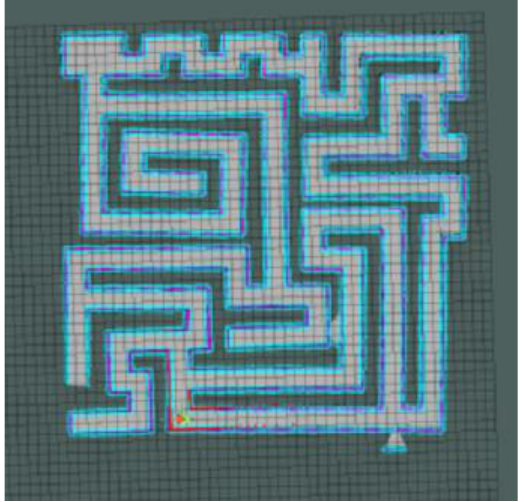
Figure 23. 3D maze modeling.